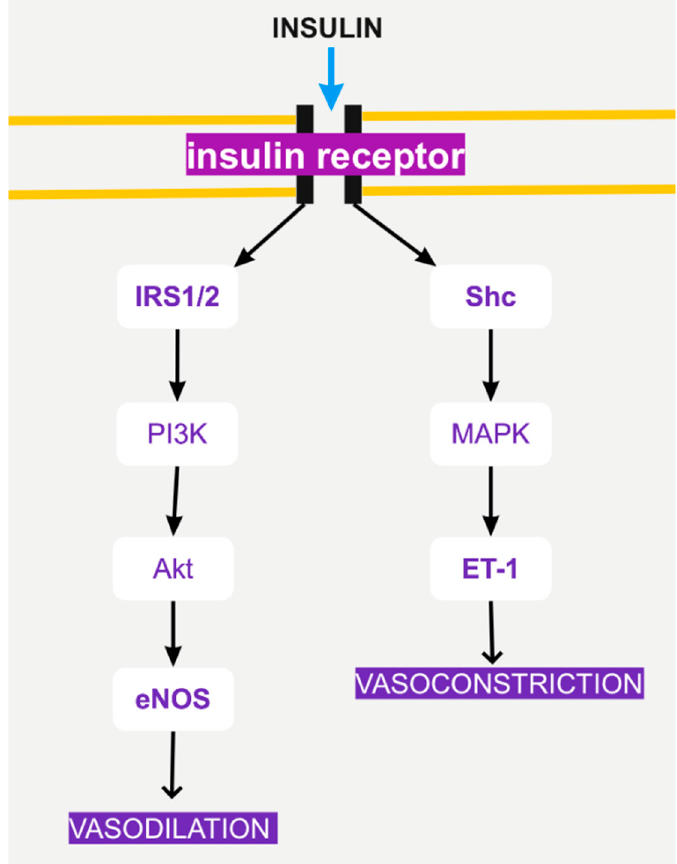
Figure 2. Insulin-signaling pathways in endothelial cells. Insulin can lead to either vasodilation or vasoconstriction, depending on the pathway.